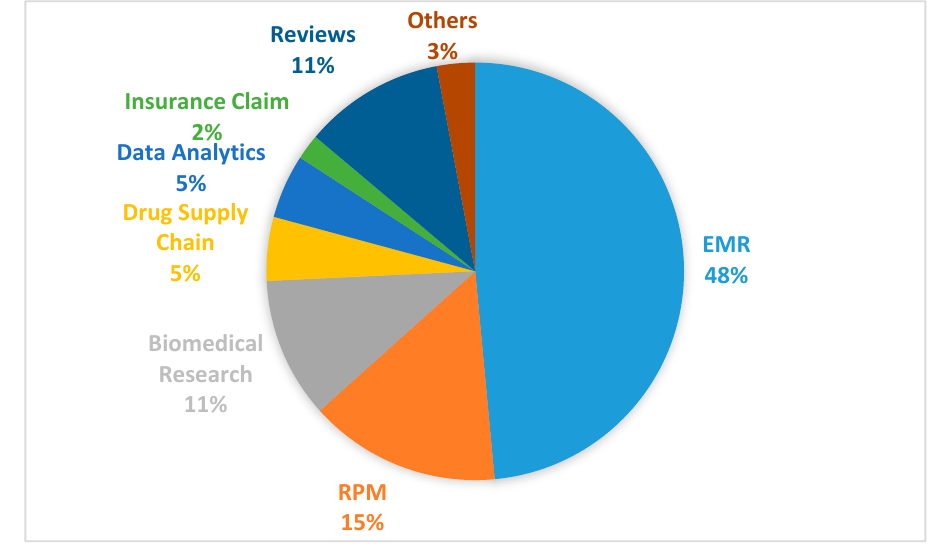
Figure 12. Percentage distribution of the selected papers.